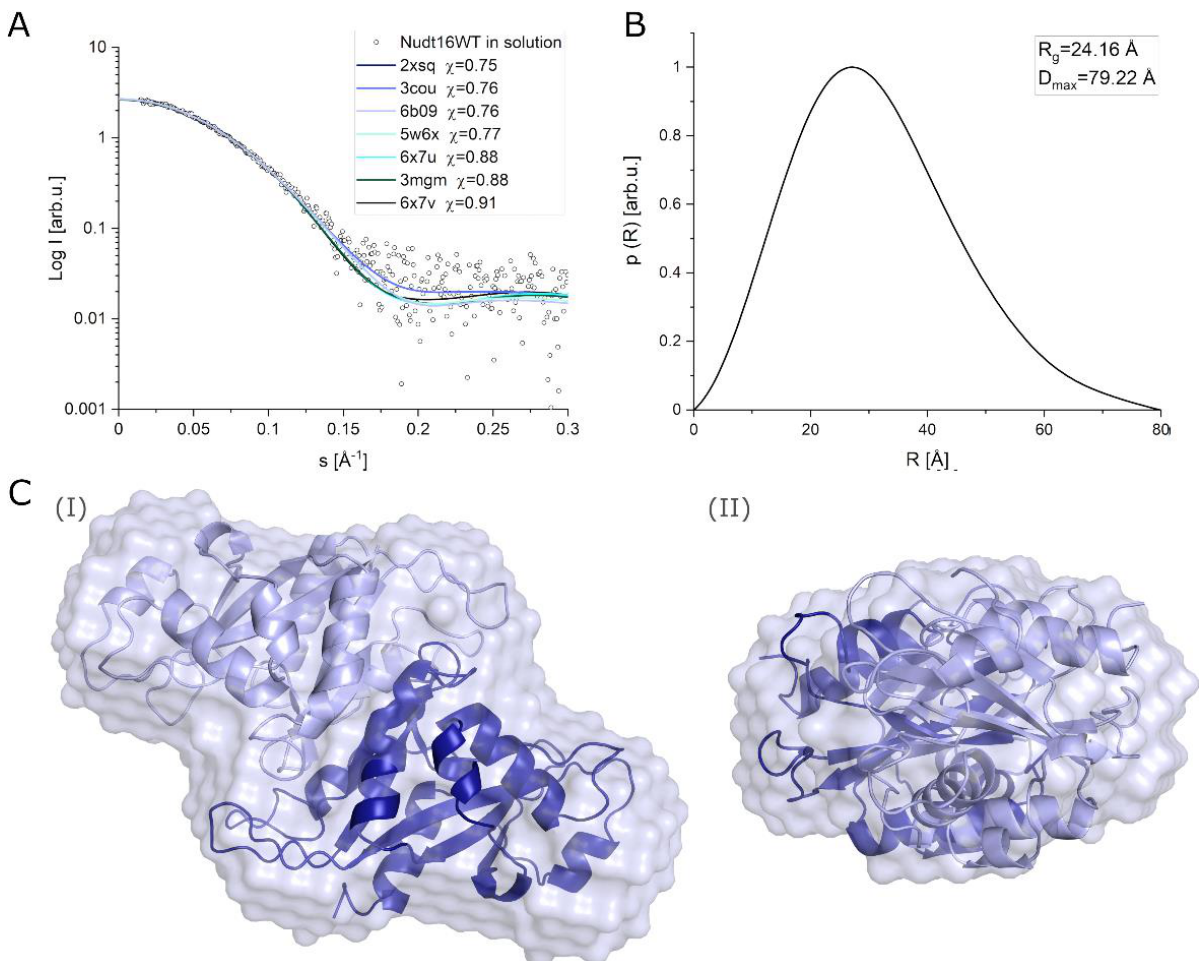
Figure 5. SAXS data analysis for hNudt16: ( A ) Comparison of experimental SAXS data for hNudt16 in solution with a fit for all crystal structures of hNudt16 dimer available in the PDB database. Theoretical scattering curves for PDB structures and discrepancy χ value (compared to SAXS data) were obtained in CRYSOL. PDB: 2XSQ had the lowest discrepancy with experimental SAXS data; ( B ) pair distance distribution function ( p (R)) determined based on SAXS scattering curve for the hNudt16 (calculated in GNOM software). The calculated structural parameters were R g = 24.16 Å and D max = 79.22 Å ; ( C ) superposition of low-resolution 3D model of hNudt16 in solution (semitransparent shape) with the crystal structure of dimeric hNudt16 PDB: 2XSQ in projections along the two axes of the molecule. Monomer-like subunits of 2XSQ dimer are marked with different colors (light and dark blue). Figures obtained in PyMOL.